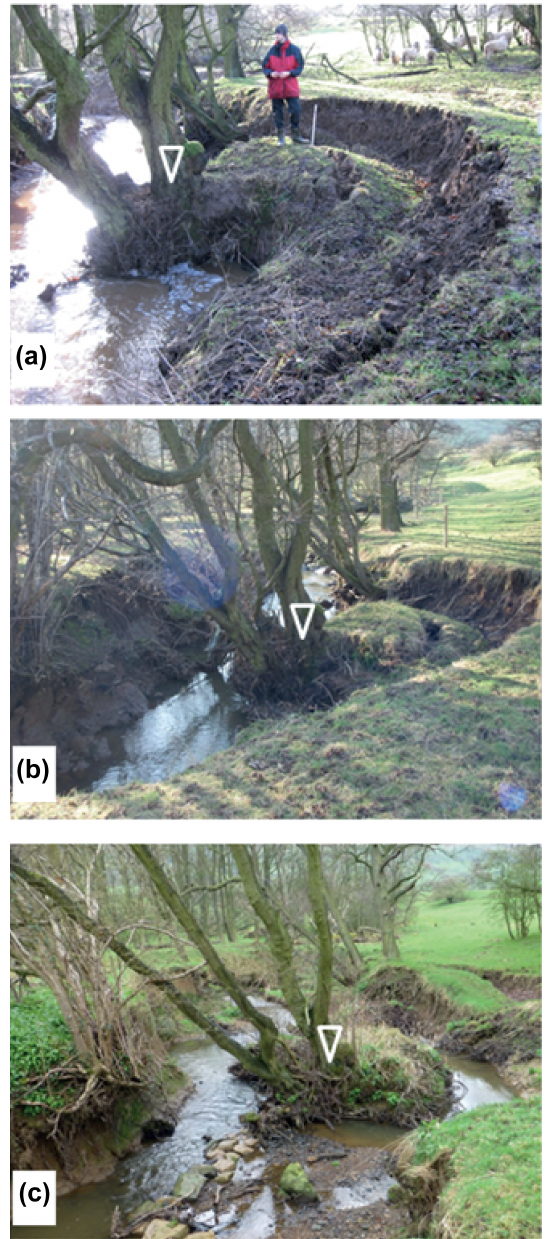
Figure 8. Time lapse sequence of a right river bank col- lapse approximately 50m upstream of channel diversion. Images show the sequence: (a) 3 February 2008; (b) 2 March 2009; and (c) 7 April 2014. The white inverted triangle shows a fixed point of reference at the base of a tree which appears in all the images.